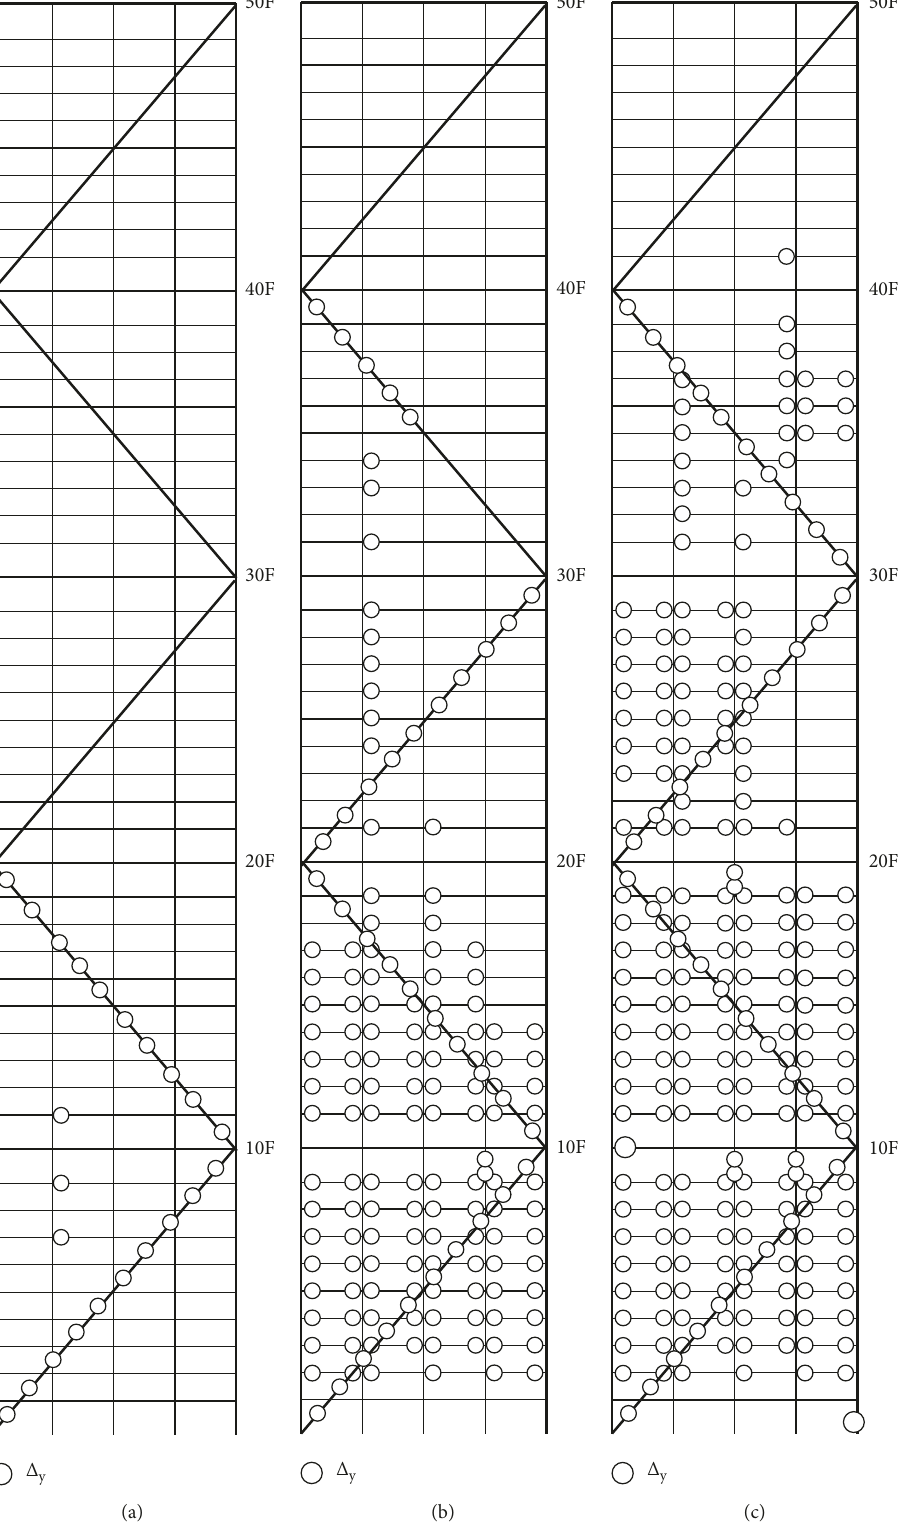
Figure 26: Plastic hinge formation in model 5MBC (web-side) by dynamic time-history analysis using El Centro earthquake input: (a) first yield; (b) secondary column; (c) primary beam and